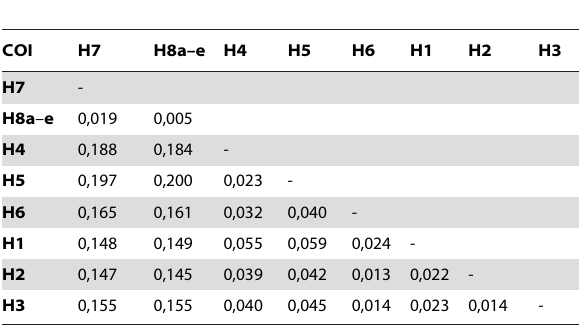
Table 1. mtDNA genetic divergence values between and within Evolutionary Significant Unit